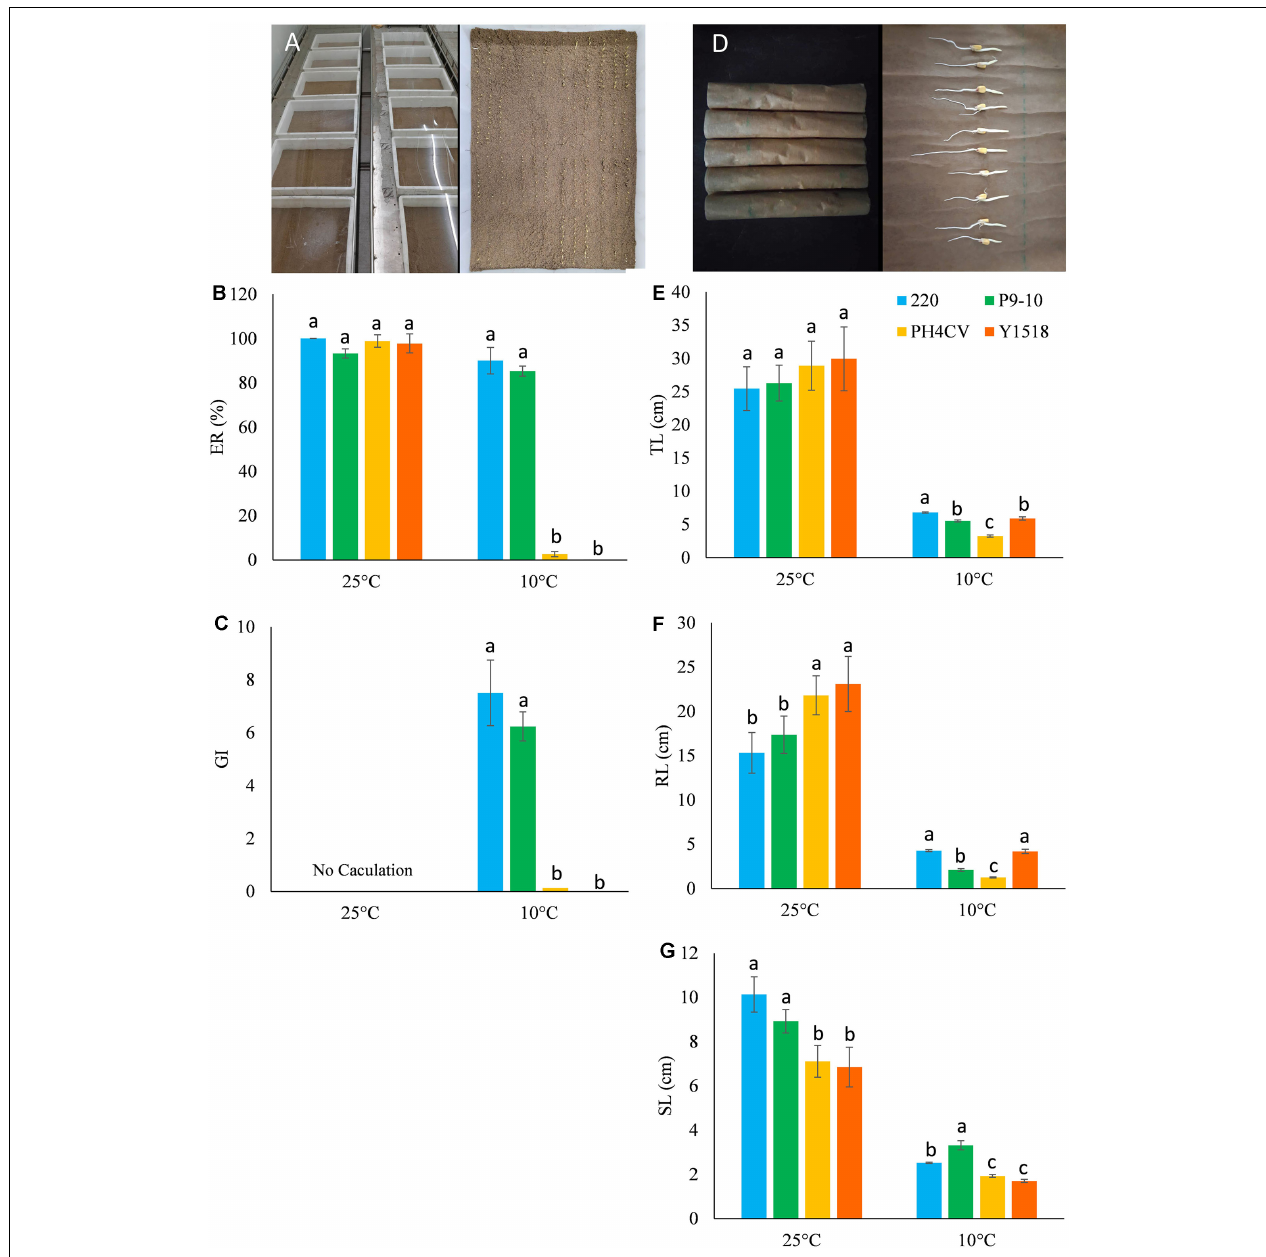
FIGURE 2 | Phenotypic performance of the four parental lines (220, P9-10, PH4CV, and Y1518) germinated under low (10 ◦ C) and normal (25 ◦ C) temperature in two germination systems of sand bed and paper rolls. (A–C) Plant germinated in sand bed. (A) Picture of sand bed; (B) ER; (C) GI. (D–G) Plant germinated in paper rolls. (D) Picture of paper rolls; (E) TL; (F) RL; (G) SL. Different small letters within a temperature treatment indicated significant differences among